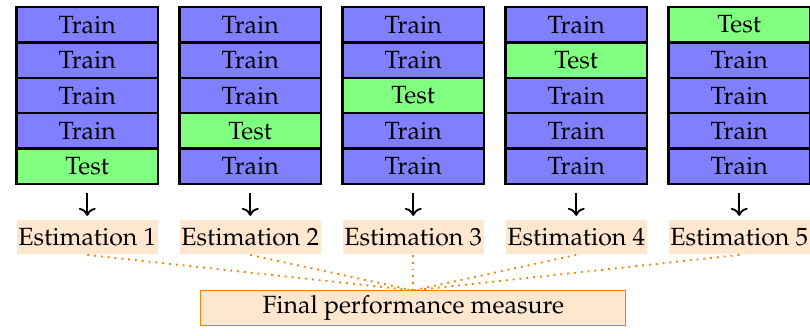
Figure 2. Model validation using 5-fold